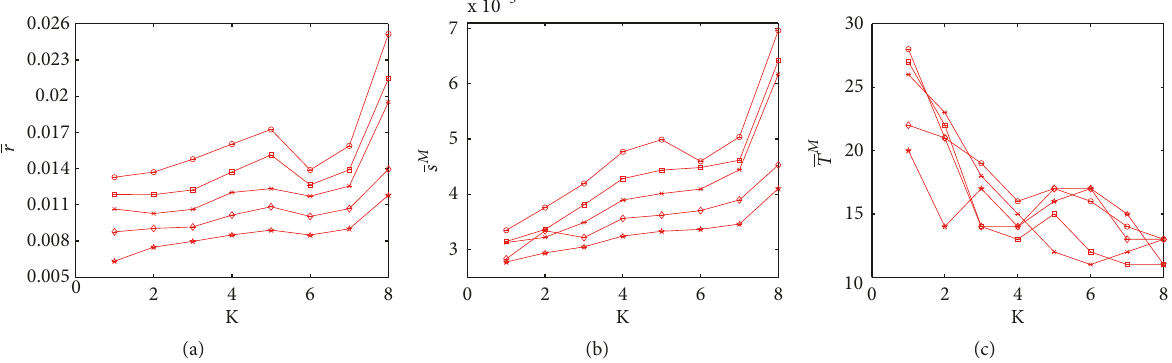
Figure 3: Three quantities of rumor propagation in Netsci: (a) the average propagation size, (b) the average peak prevalence, and (c) the arrival time of the average peak prevalence when the spreading rate 𝛼 = 0.1(𝑠𝑡𝑎𝑟𝑠) , 𝛼 = 0.15(𝑑𝑖𝑎𝑚𝑜𝑛𝑑𝑠) , 𝛼 = 0.2(𝑓𝑜𝑟𝑘𝑠) , 𝛼 = 0.25(𝑠𝑞𝑢𝑎𝑟𝑒𝑠) , and 𝛼 = 0.3(𝑐𝑖𝑟𝑐𝑙𝑒𝑠) , respectively, and the decay rate 𝛽 = 1 . The performance of nodes in the higher layer is